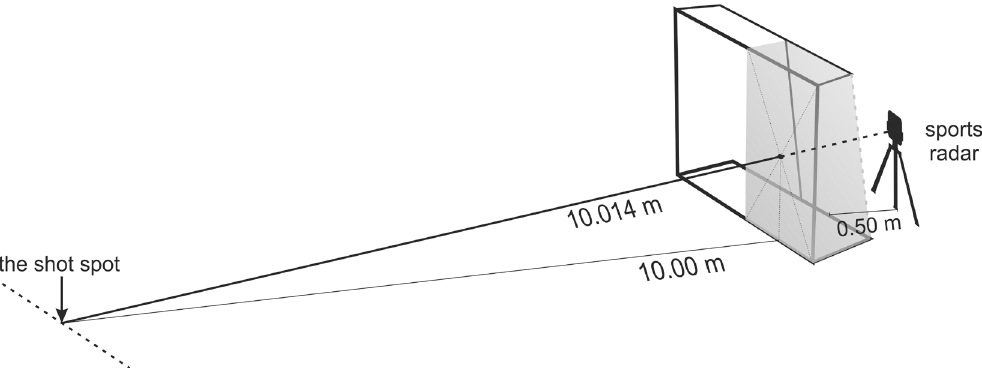
Figure 1. Setup of on-ice